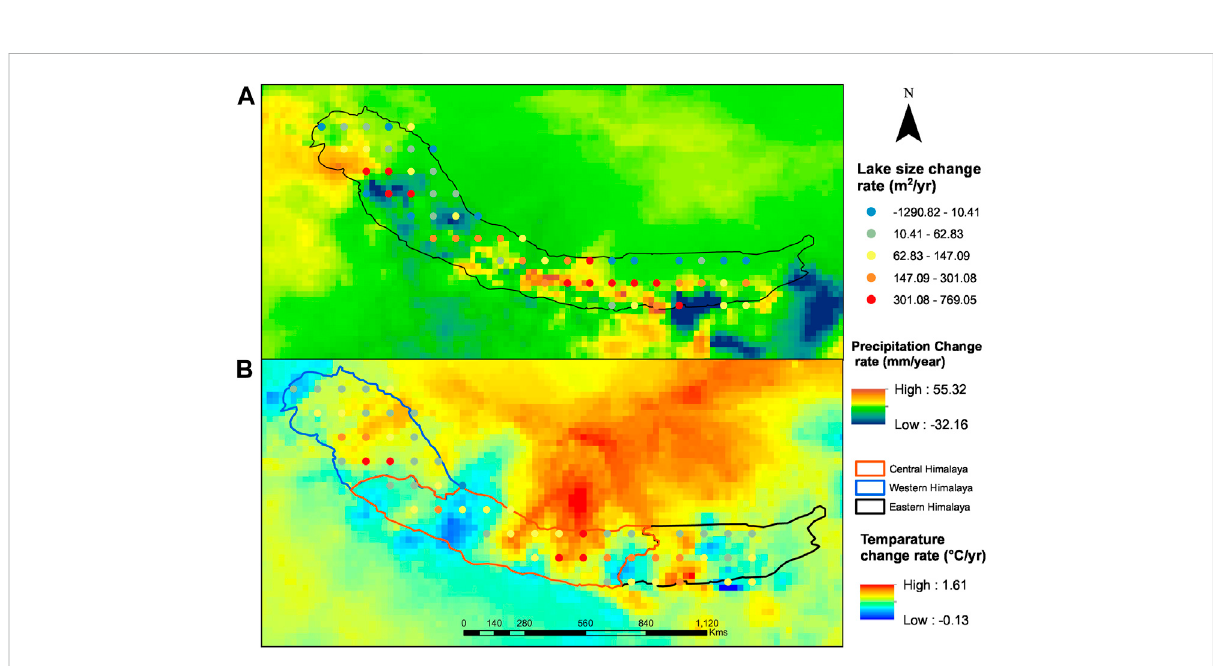
FIGURE 6 Precipitation (A) and temperature (B) change rate is shown with their corresponding average lake size change rate in the